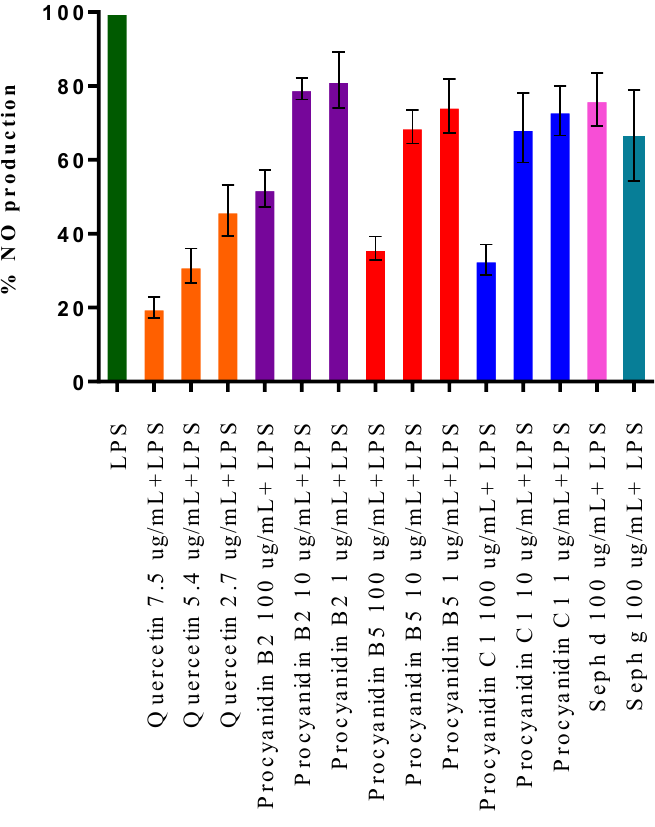
Figure 3. Effects of procyanidins and proanthocyanidin-rich fractions of aronia on NO production in LPS-activated RAW 264.7 macrophages. Quercetin was used as a positive control. Each bar represents the mean ± SD of three individual